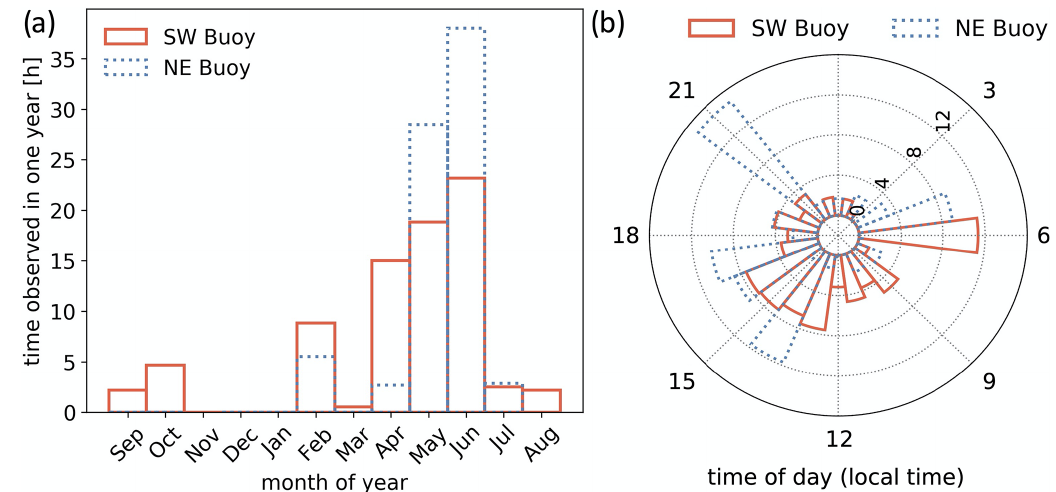
Figure 11. Number of hours (over the entire year) in which LLJs were observed at both buoys as a function of month (a) and time of day (b) . Distributions consider all 10min profiles featuring an